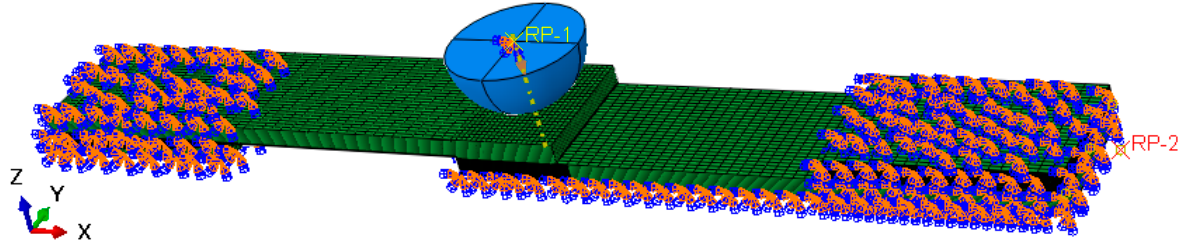
Figure 4. The finite element model (FEM) of LVI and TAI of carbon fiber reinforced polymer (CFRP) laminate SLJs adhesively bonded structures.